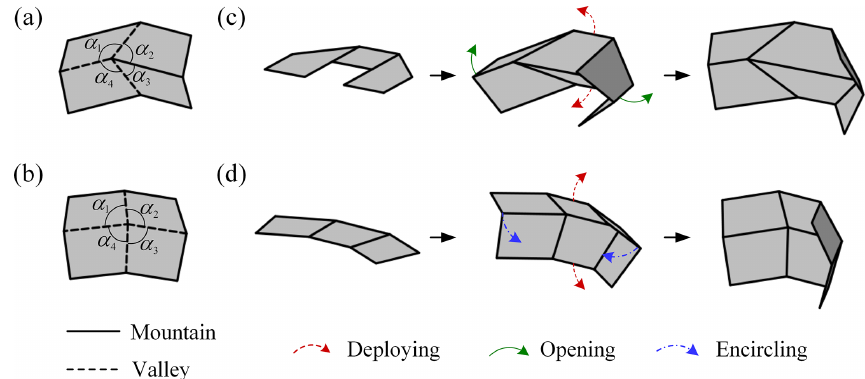
Figure 1. Schematic representation of the research workflow.